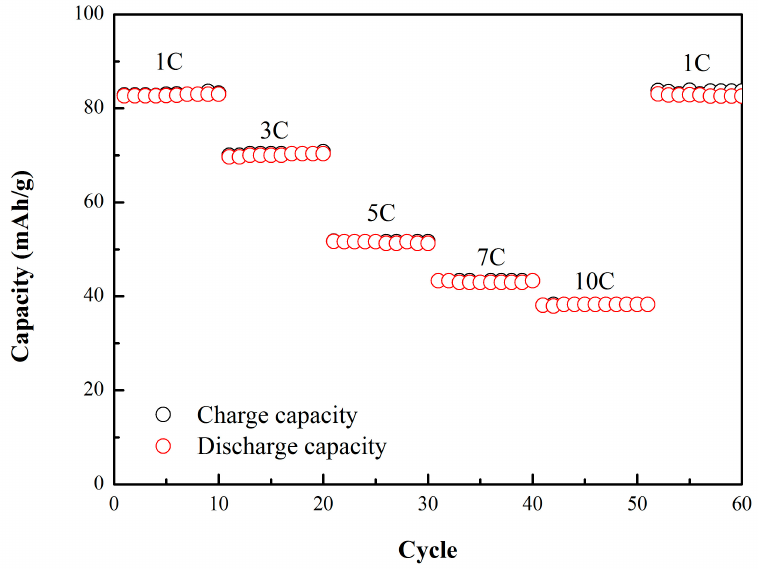
2 graphite electrode at different